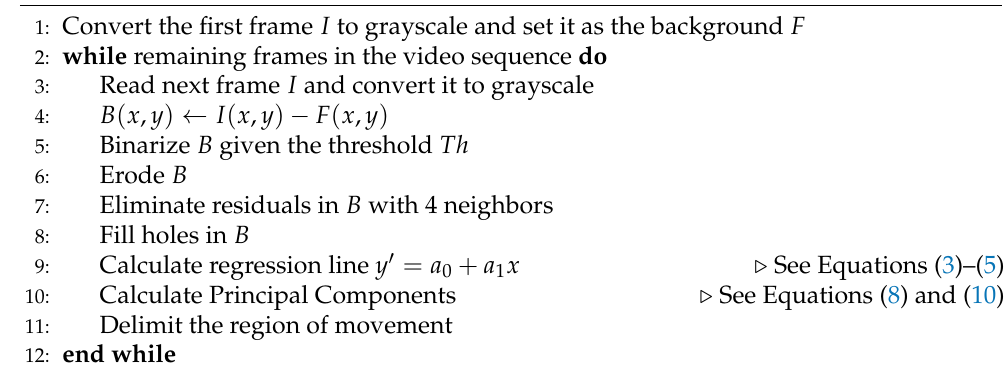
Algorithm 1 The basic sequence of the detection of motion with the MDBS